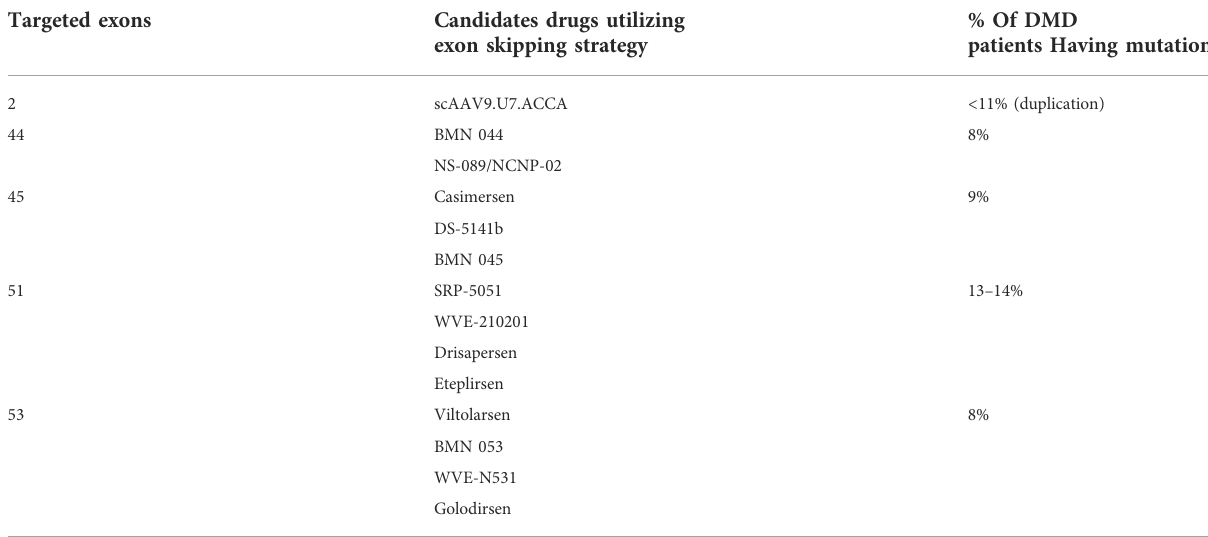
TABLE1Drugs orcandidatesfor exonskipping,theirtargetedexons inthedystrophingene,and thepercentageofDMDpatients havingmutations in the targeted exons (Aartsma-Rus et al., 2009; Bladen et al., 2015; Vulin et al., 2015). The candidate drug, scAAV9.U7.ACCA, delivers small nuclear RNA (snRNA) using AAV9 for skipping one or two copies of exon 2 in DMD patients with exon 2 duplication. Targeted